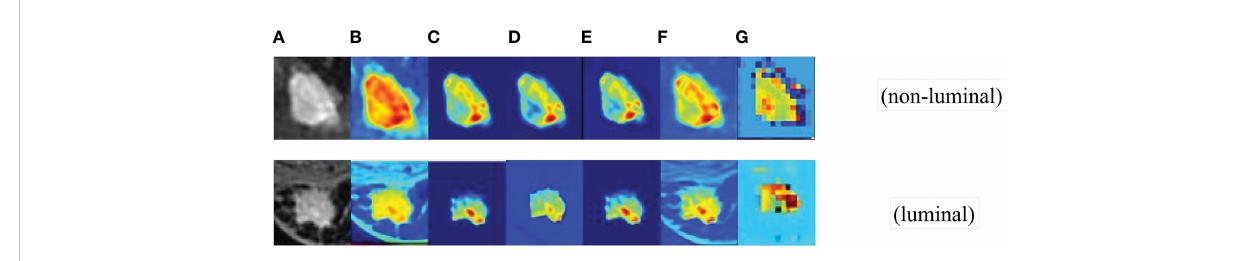
FIGURE 5 The visual images of feature. (A) the feature Source images. (B) the fi rst convolutional layer images. (C) SFEpath images. (D) LTTpath1 images. (E) LTTpath2 images. (F) the three branches fused images. (G) DEFM